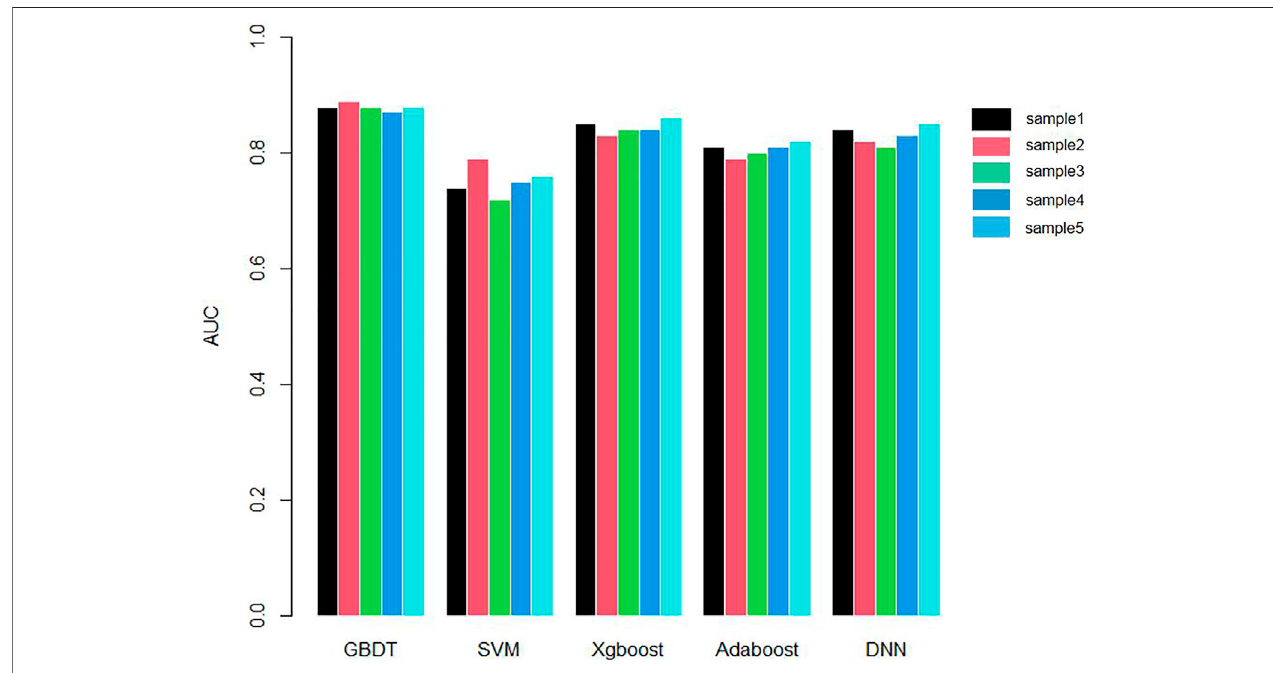
FIGURE 3 | Comparison chart of AUC values of fi ve methods.